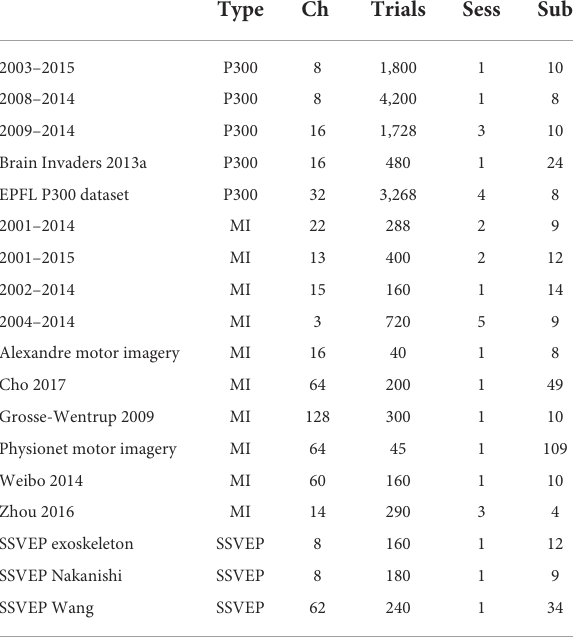
TABLE 1 List of the processed databases for event-related potentials, motor imagery paradigms, and steady-state visual evoked